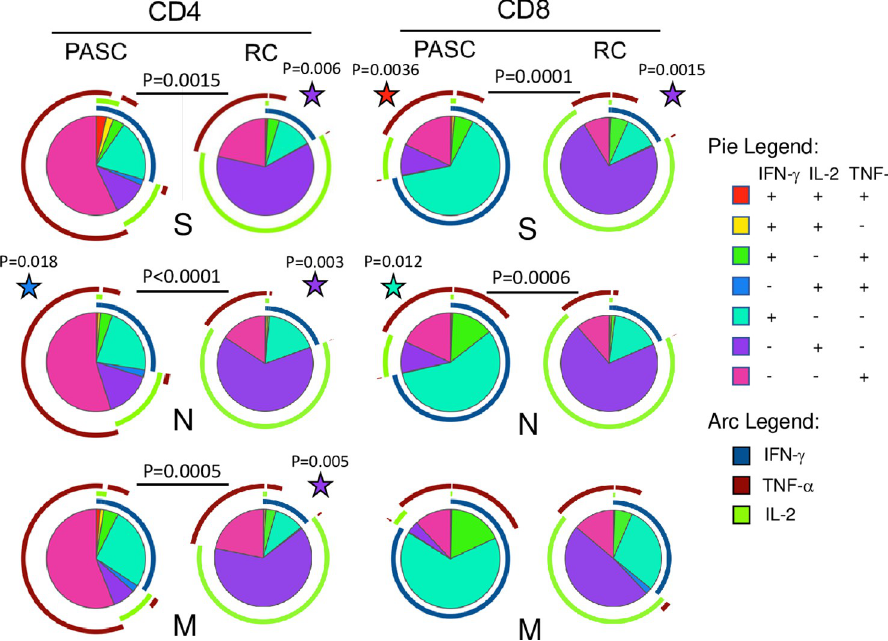
Fig 2. Cytokine co-expression of SARS-CoV-2 specific T cells differs between PASC and RC. Cytokine co- expression on SARS-CoV-2 specific T cells visualized using simplified presentation of incredibly complex evaluations (SPICE) analysis. Each pie chart represents the proportions of combinations of IFN- γ , TNF- α and IL-2 producing T cells in response to one SARS-CoV-2 protein. Arcs surrounding each pie chart depict the proportion of cells secreting each individual cytokine. Colors of pie charts and arcs represent different cytokines or combinations of cytokines and are listed in the corresponding legend. Stars denote significant differences determined by student t test corrected for multiple comparsons between PASC and RC cohorts for a particular combination of co-expressed cytokines matching as indicated by the color corresponding to the pie legend. Stars are positioned next to the cohort with the higher proportion. P values positioned between PASC and RC pie charts denote statistical significance of overall composition by permutation test with 10,000 iterations corrected for multiple comparsons.